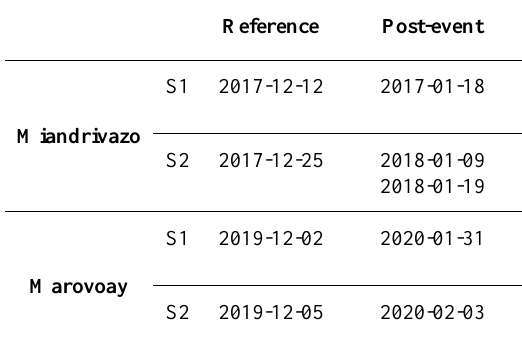
Table 1. Sentinel-1 and 2 images used for change